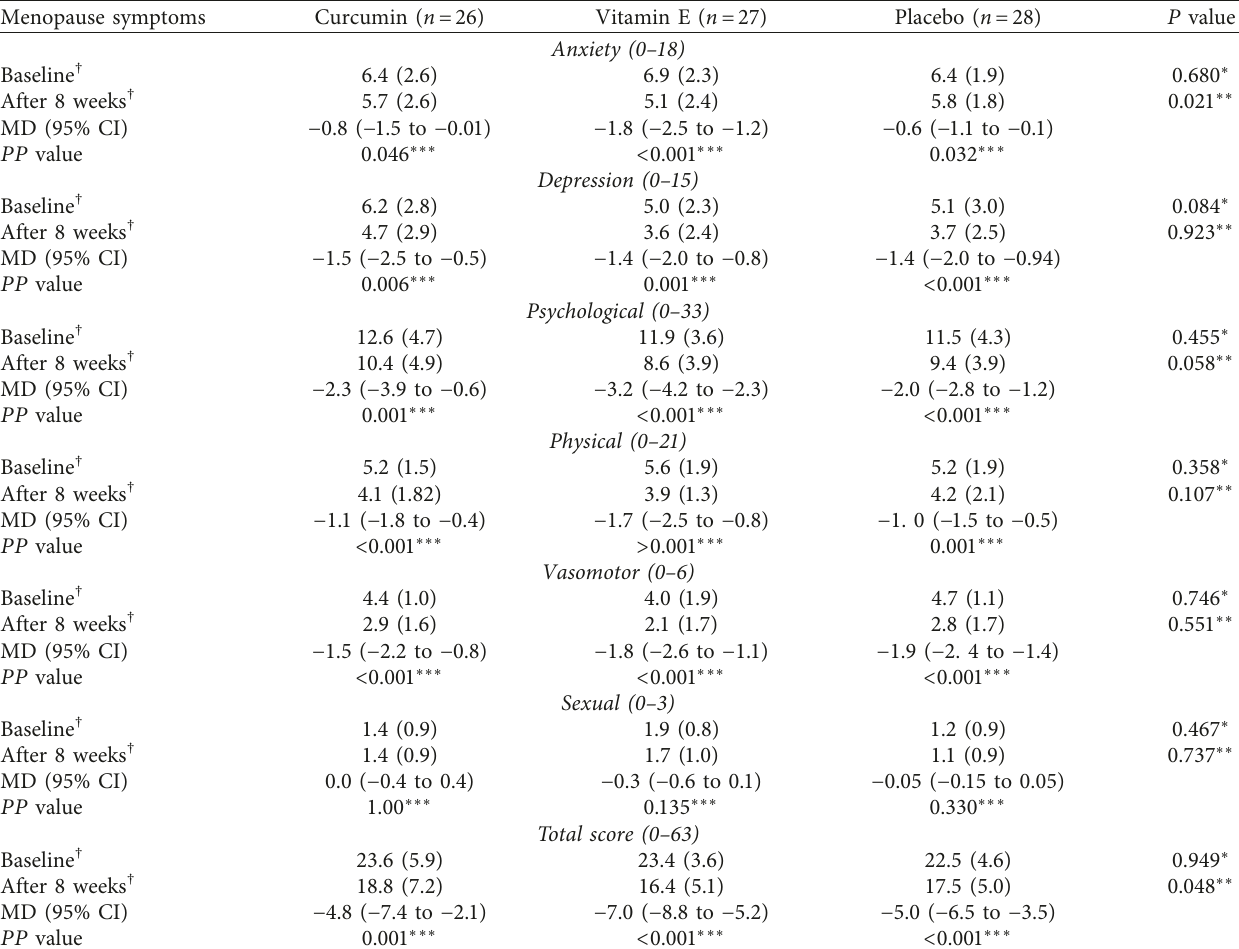
Table 3: The score of menopause symptoms among the study groups.